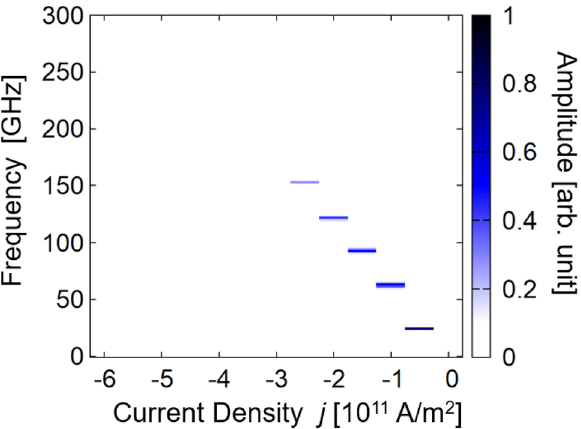
Figure 3. Dependence of f on j estimated from Fourier spectrum for ( J 1 , J 2 ) = ( 0.6, − 0.6 ) mJ/m 2 . The Fourier spectrum amplitude is indicated by the color